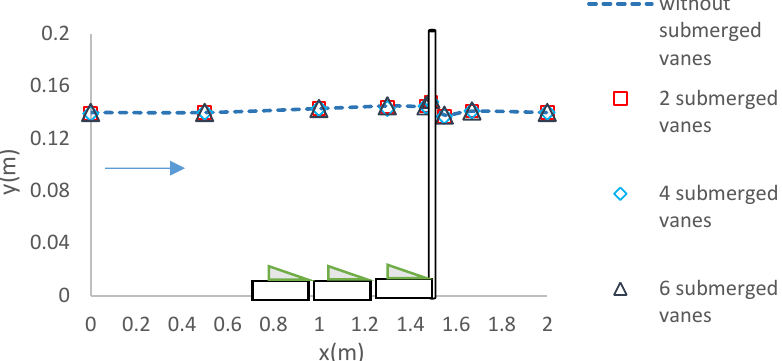
Fig.9. comparison of the water surface profile at Z = 0, 𝑉/𝑉𝑐 = 0.95 , 𝛼 = 30˚